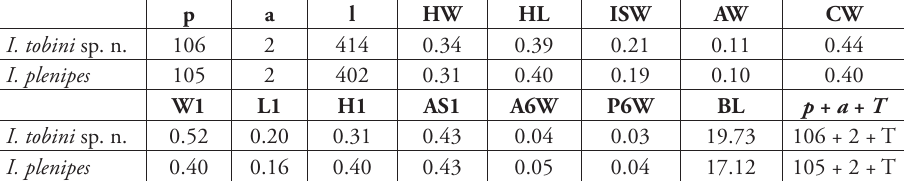
Table 2. Comparison of measurements between I. tobini sp. n. vs a male I. plenipes individual with an equivalent number of rings (VTEC catalog #